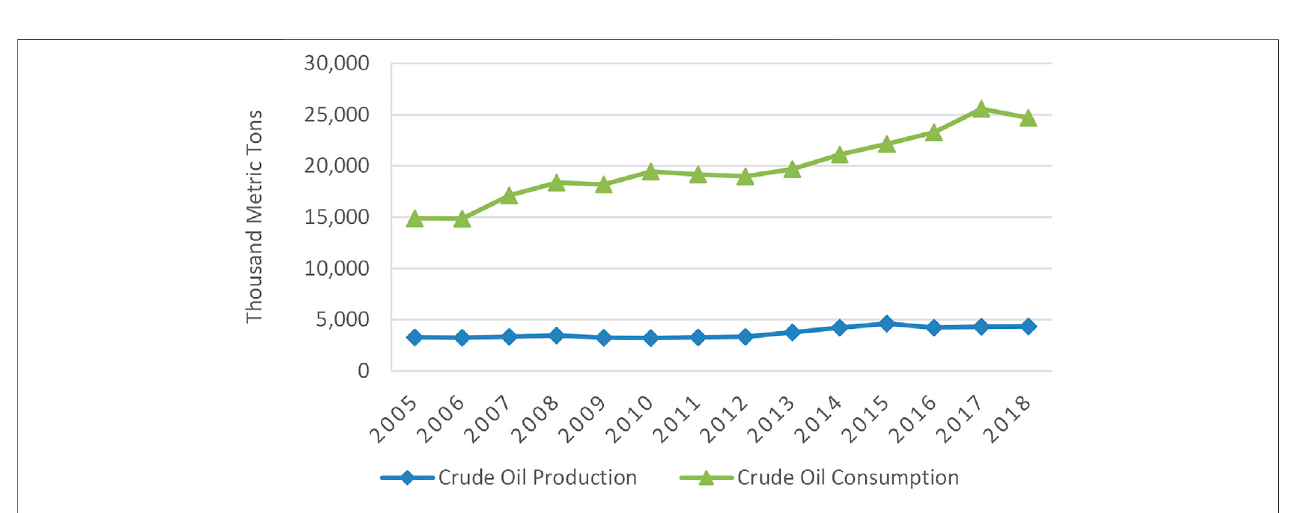
FIGURE 2 | Pakistan ’ s crude oil production and consumption 2